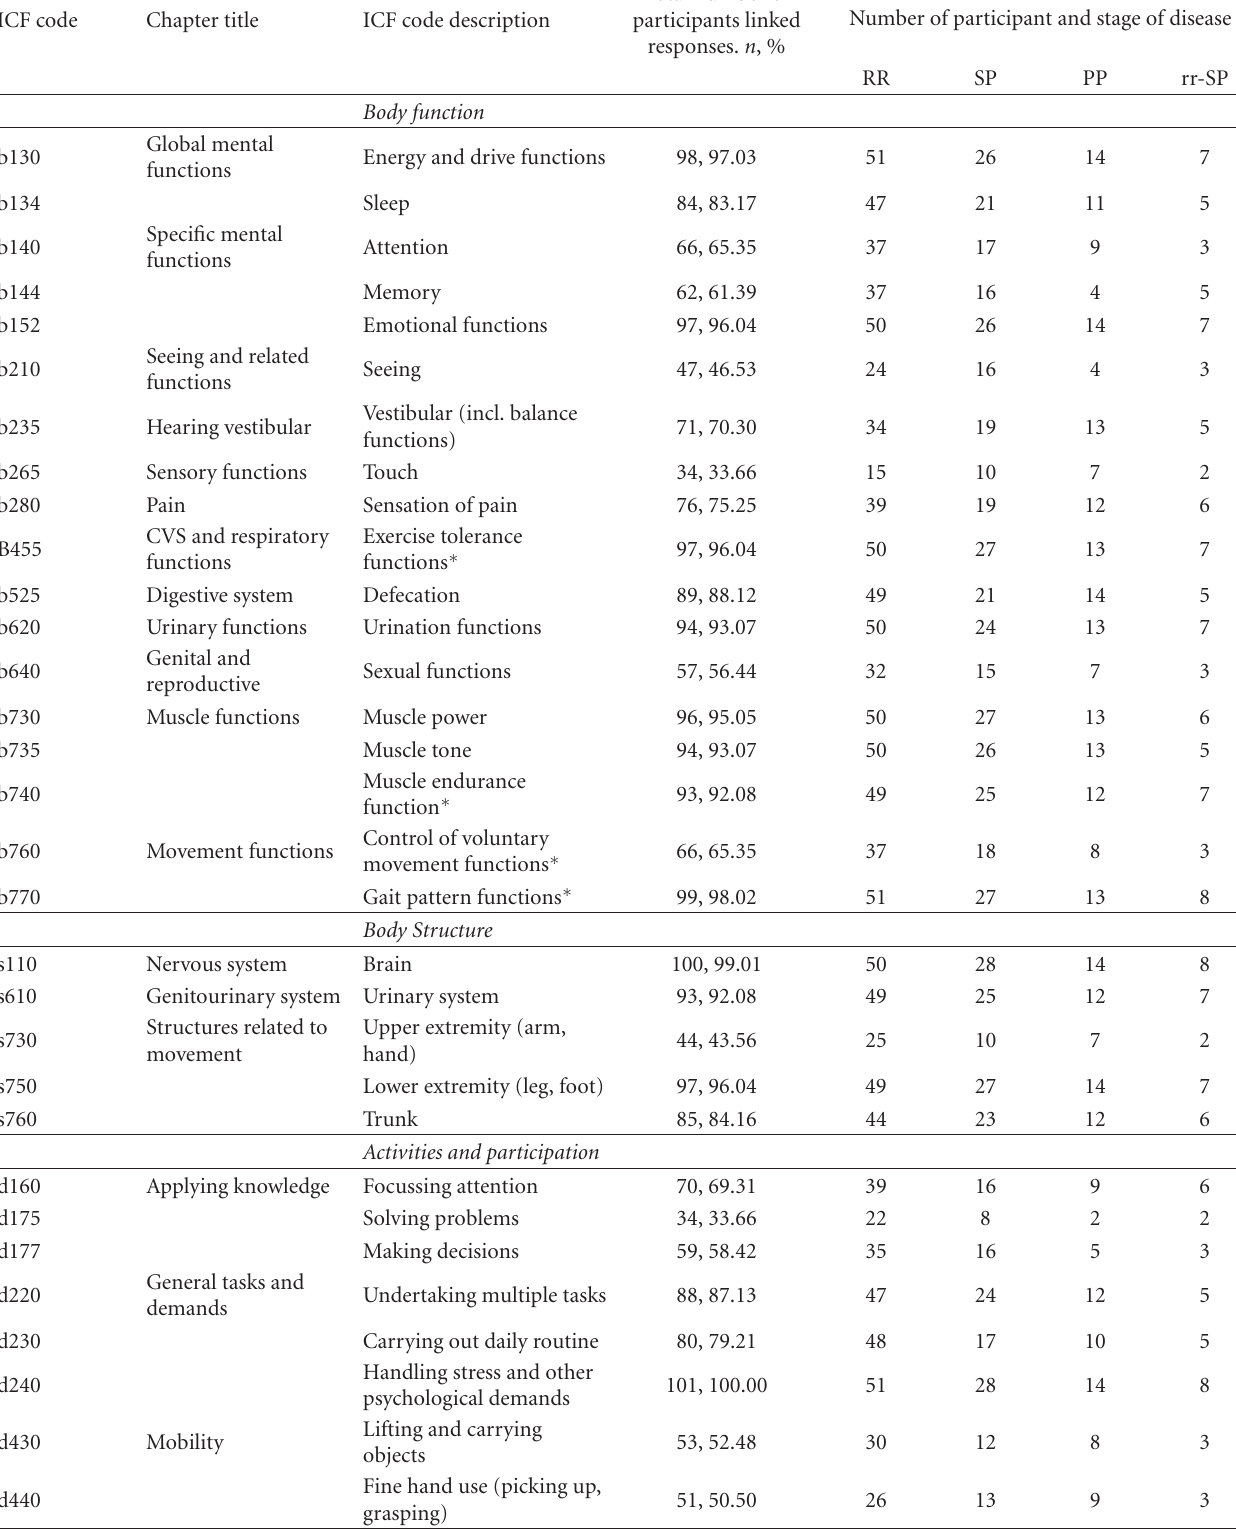
Table 5: Frequency of limitations reported by persons with MS ( N = 101) linked with ICF categories for the components: body function, body structure, activity and participation, and environmental factors (those reported by at least one third of MS patients are listed